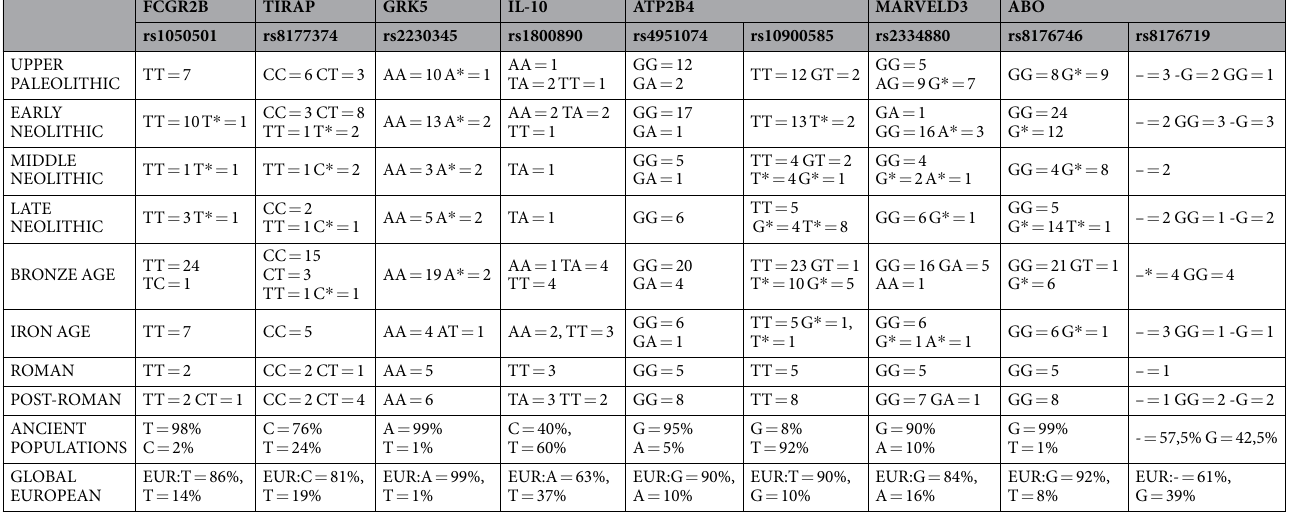
Table 2. Frequencies of malaria-resistant alleles by time period in nine selected genes and 224 available ancient European genomes. The frequencies of current European populations are displayed below the